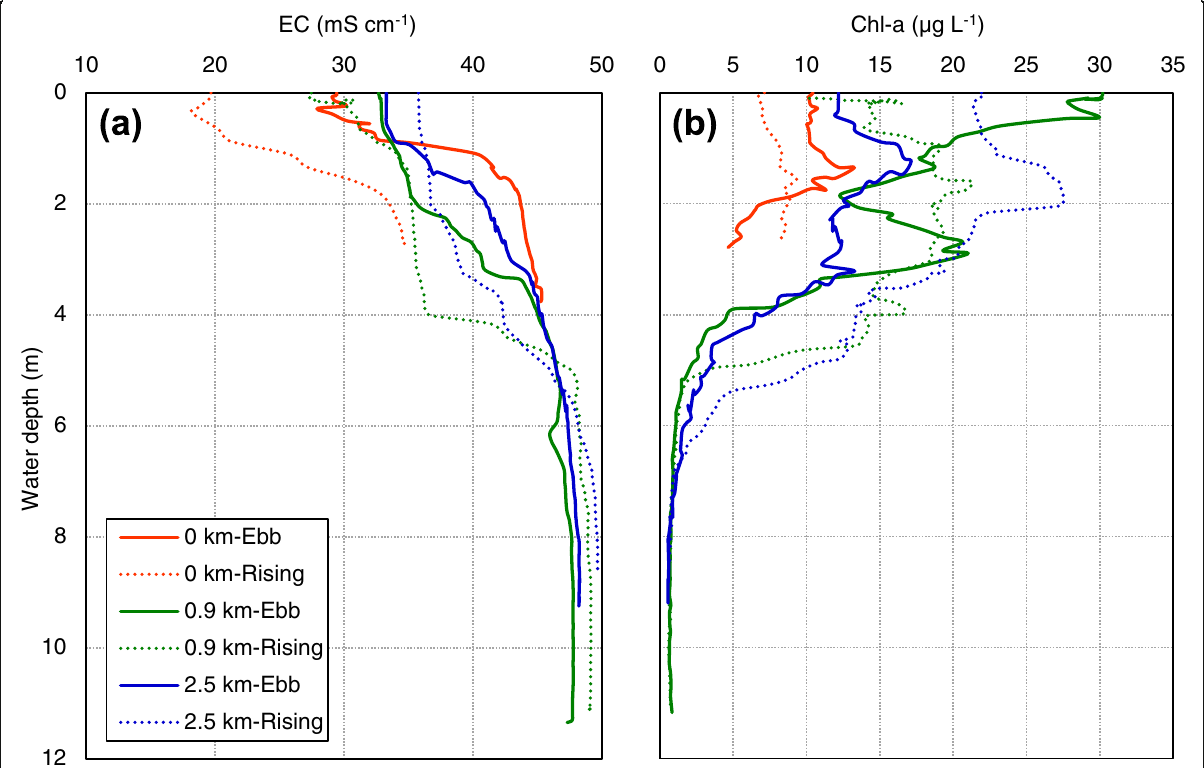
Fig. 4 Vertical profiles of a EC and b Chl-a from the STP to 2.5 km offshore on the KH line during the ebb and rising tide periods in September